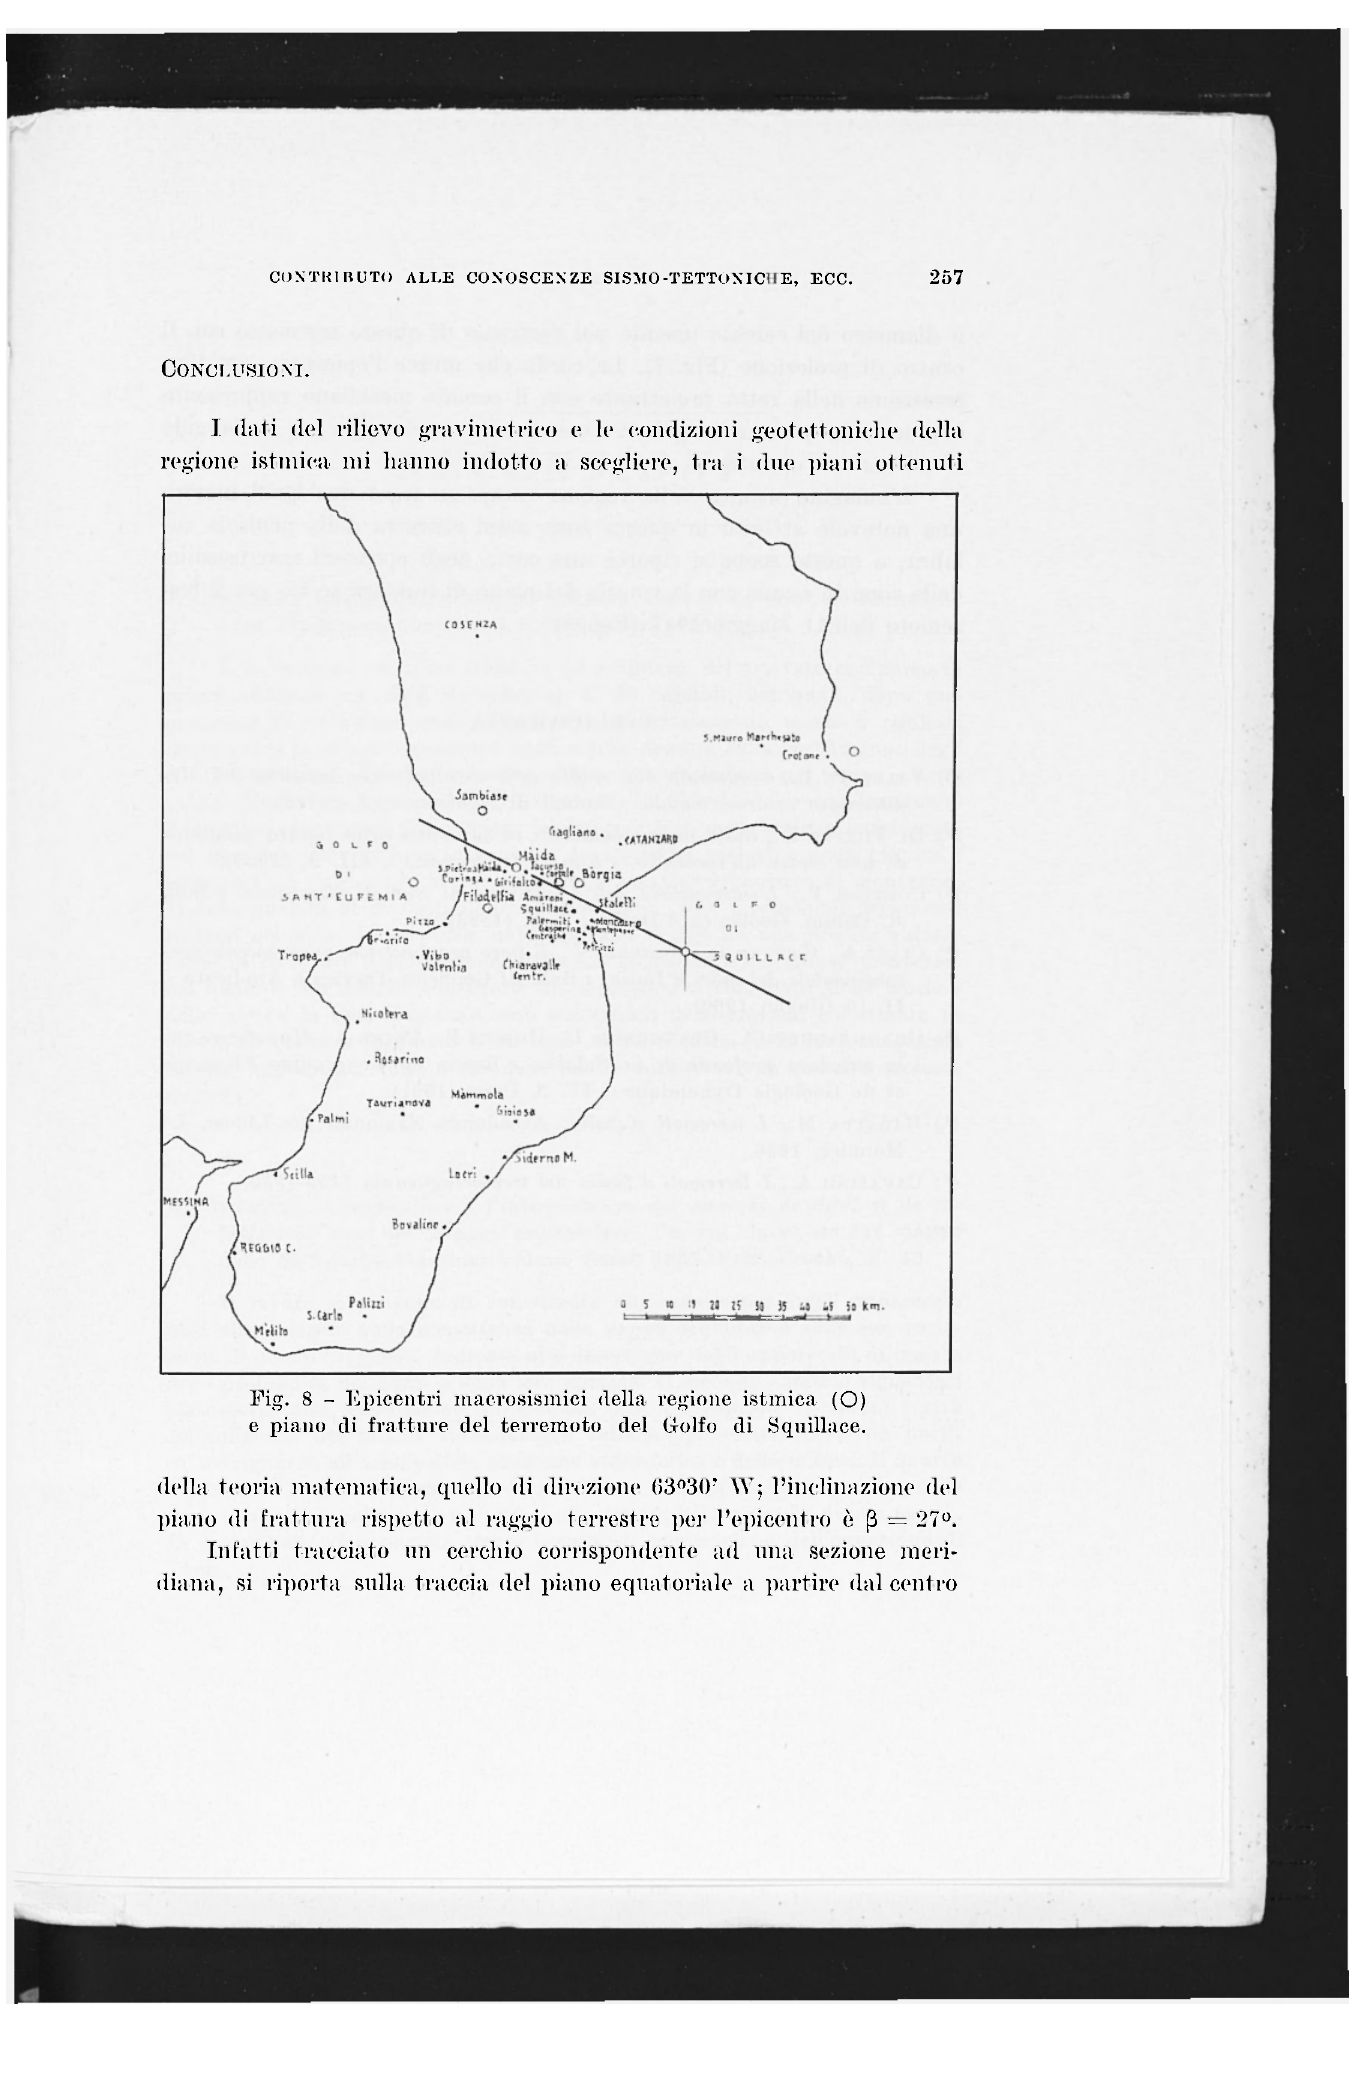
Fig. 8 - Epicentri macrosismici della regione istmica